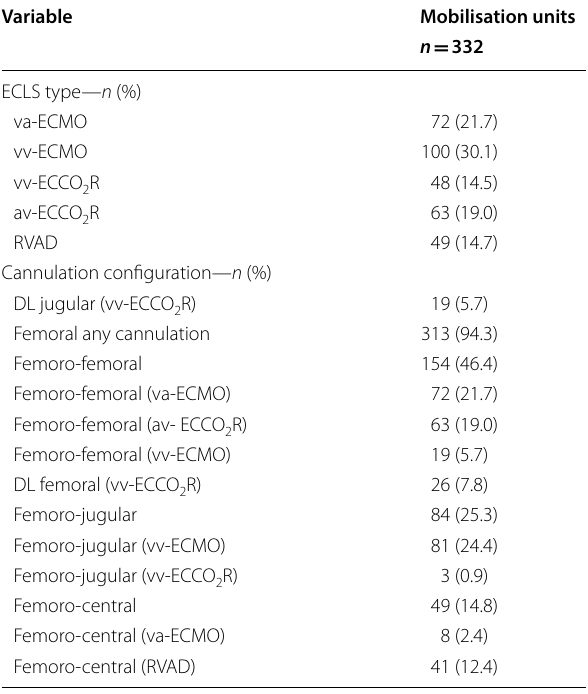
Table 3 Active mobilisation units (IMS to ECLS type and cannulation